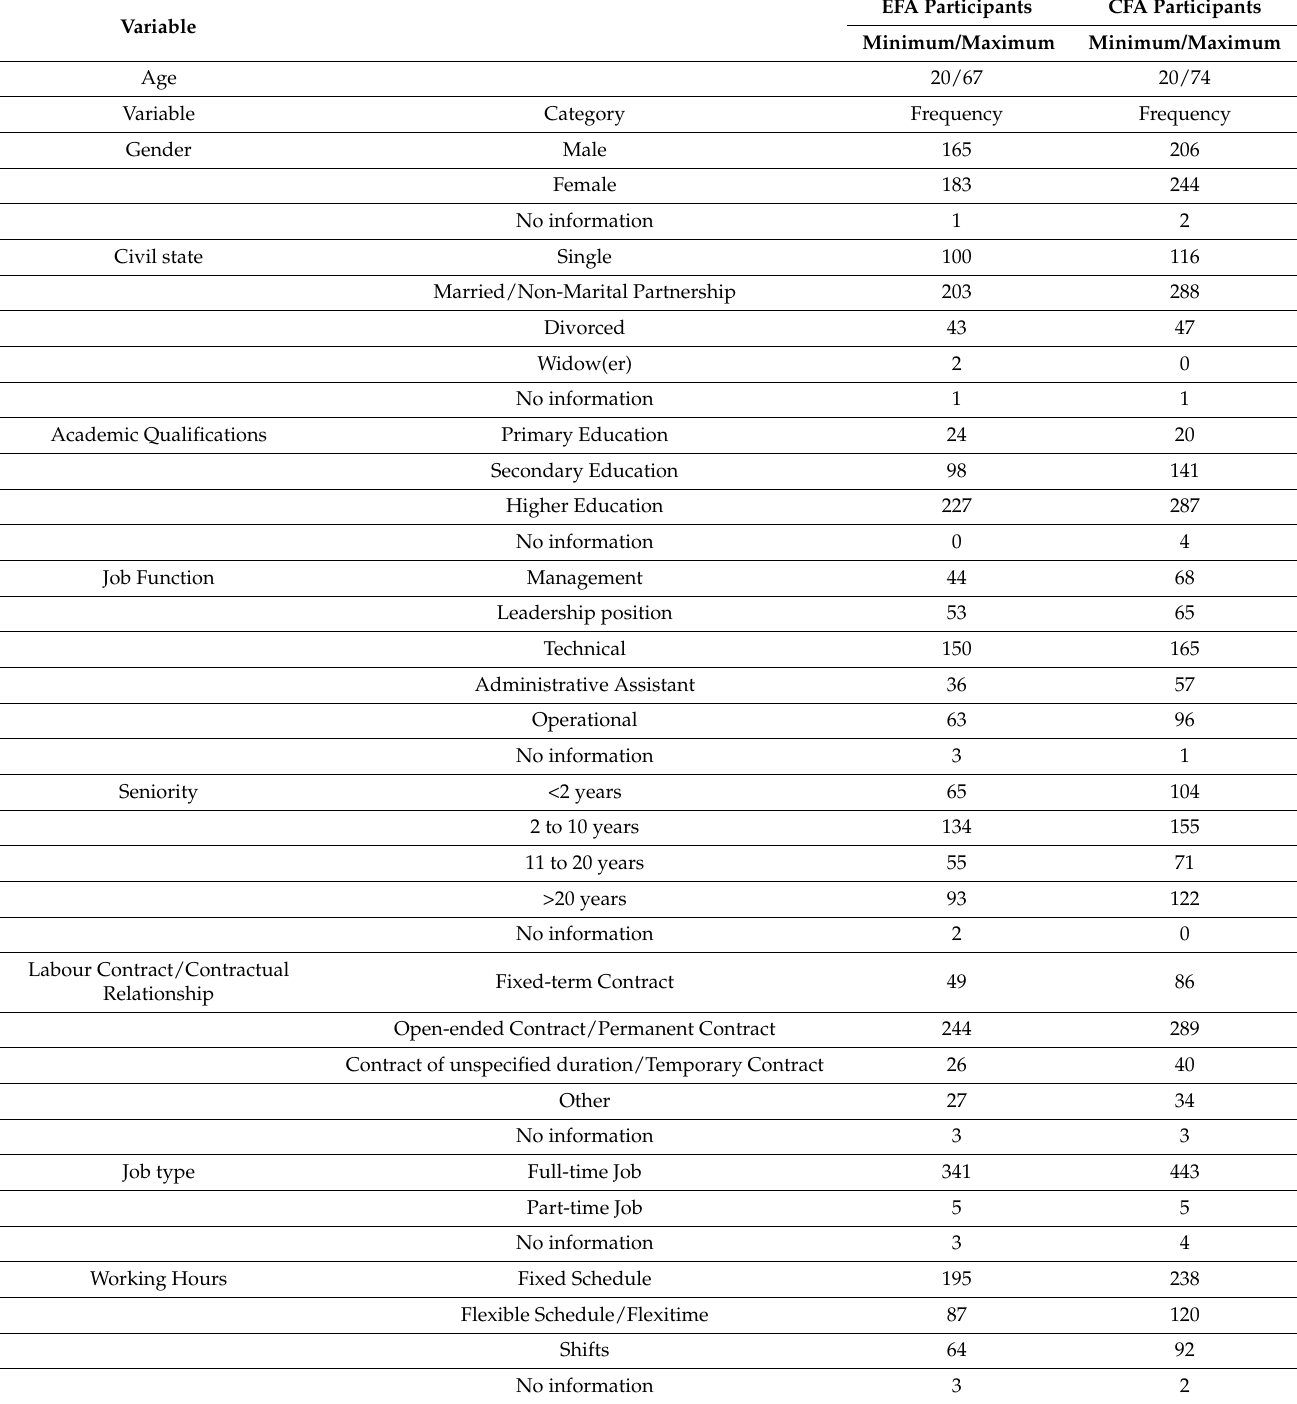
Table 4. Distribution of Population Data with EFA and